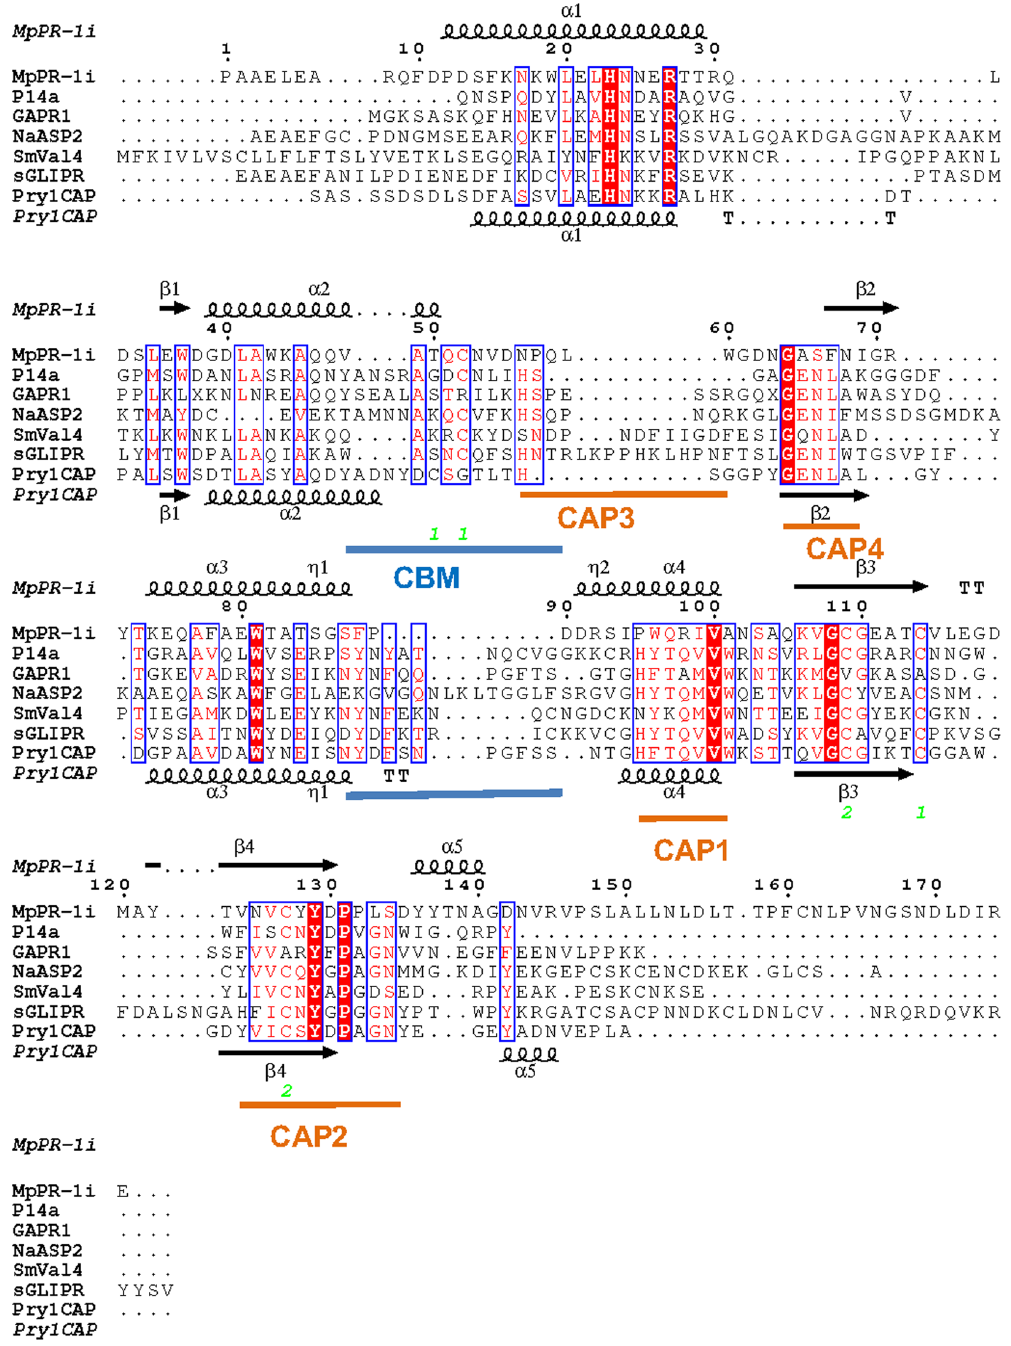
Figure 4. SCP/TAPS protein motifs. Structural features of MpPR-1i and primary sequence alignment with SCP/TAPS proteins that are most structurally similar. This figure was generated with ESPript 56 . The different secondary structure elements shown are alpha helices as large squiggles labelled ( α ), 3 10 -helices as small squiggles labelled ( η ), beta strands as arrows ( β ), and beta turns (TT). Identical residues are shown in white on red background, and conserved residues in red. The locations of the cysteine residues involved in disulfide bonds are numbered in green. CAP motifs are highlighted in orange, and caveolin-binding motif is indicated in blue. The SCP/TAPS structures with pdb accension codes in parenthesis are Na -ASP-2 (1u53), SmVAL4 (4p27), PI14a (1cfe), GAPR-1 (1smb), Pry1CAP (5ete), and sGLIPR1 (PDB entry